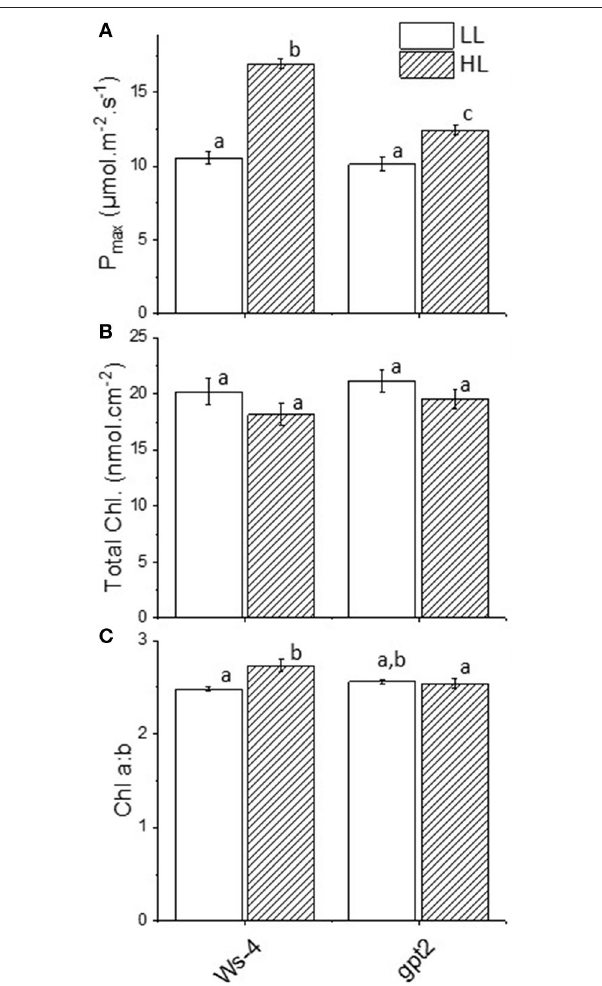
FIGURE 1 | Acclimation responses in Wassilewskija-4 (Ws-4) wild type and glucose-6-phosphate/phosphate translocator 2 ( gpt2 ) mutant plants. Plants were grown for 7 weeks at an irradiance of 100 µ mol m − 2 s − 1 before either remaining at that irradiance (low light; LL) or being transferred to 400- µ mol m − 2 s − 1 (high light; HL) conditions for 7 more days. (A) Photosynthetic capacity (P max ) measured as the rate of photosynthesis in 2,000 µ l L − 1 CO 2 and 1,500 µ mol m − 2 s − 1 light. (B) Total chlorophyll content. (C) Chlorophyll a : b. Significance of the treatments were indicated with different lowercase letters, at p ≤ 0.05 (ANOVA/Tukey, n = 4).